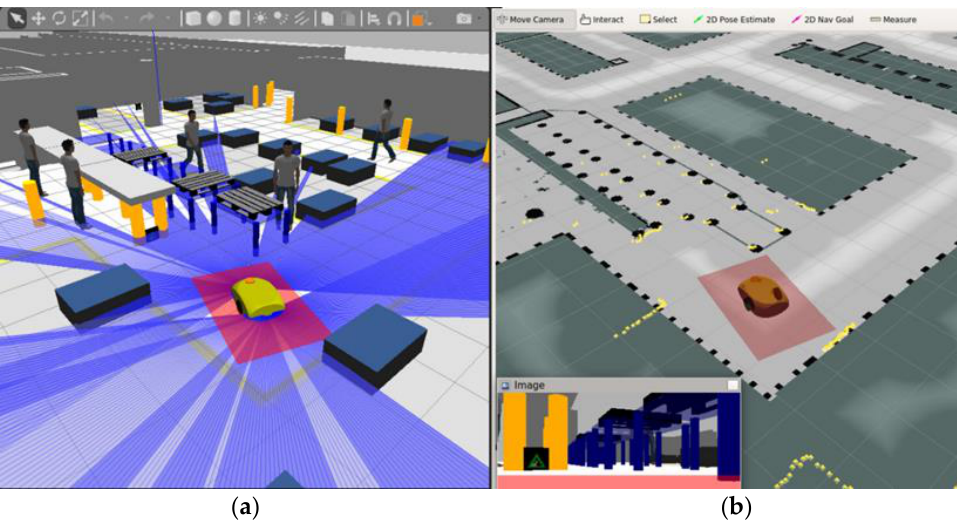
Figure 6. View of digital twin of real AMR in Gazebo simulator ( a ). Visualization of estimated AMR pose on the occupancy grid of production hall ( b ).